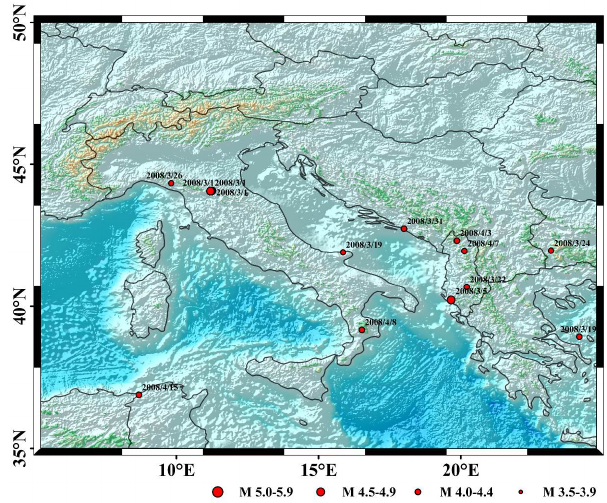
Fig. 2. Historic seismicity (March 2008 to April 2008) of the Figure 2. Historic seismicity (March 2008 to April 2008) of Abruzzo region. 2 Abruzzo